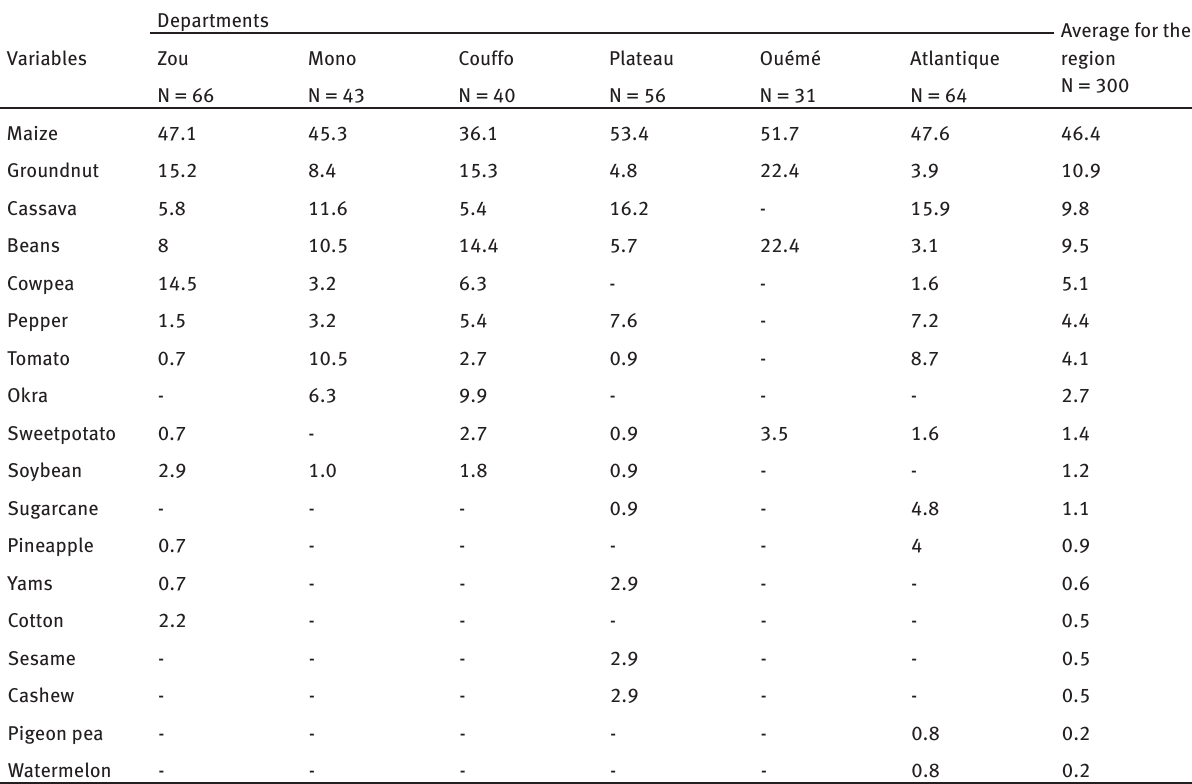
Table 3 : Farmers perceptions of crop most attacked by termites in southern Benin